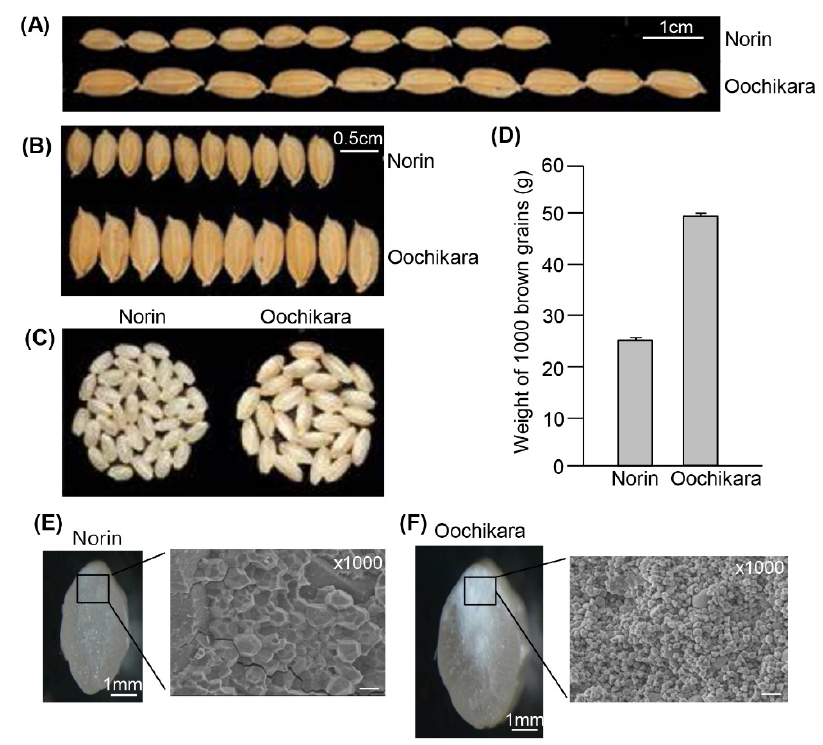
Figure 1. Phenotypic analysis of wild ‐ type and gw2 mutant grains. ( A – C ) Grain phenotypes of Norin and Oochikara. Grain length ( A ) and width ( B ) of ten seeds of Norin and Oochikara. Brown grains from which husks were removed ( C ). ( D ) Weight of 1000 brown grains of Norin and Oochikara. Error bars indicate standard deviations ( n = 3); Palea and lemma of the grains of Norin ( E ) and Oochikara ( F ) were removed. The seeds were hand-sectioned with a razor blade transversely and then analyzed by SEM. Scale bar, 10 µm.